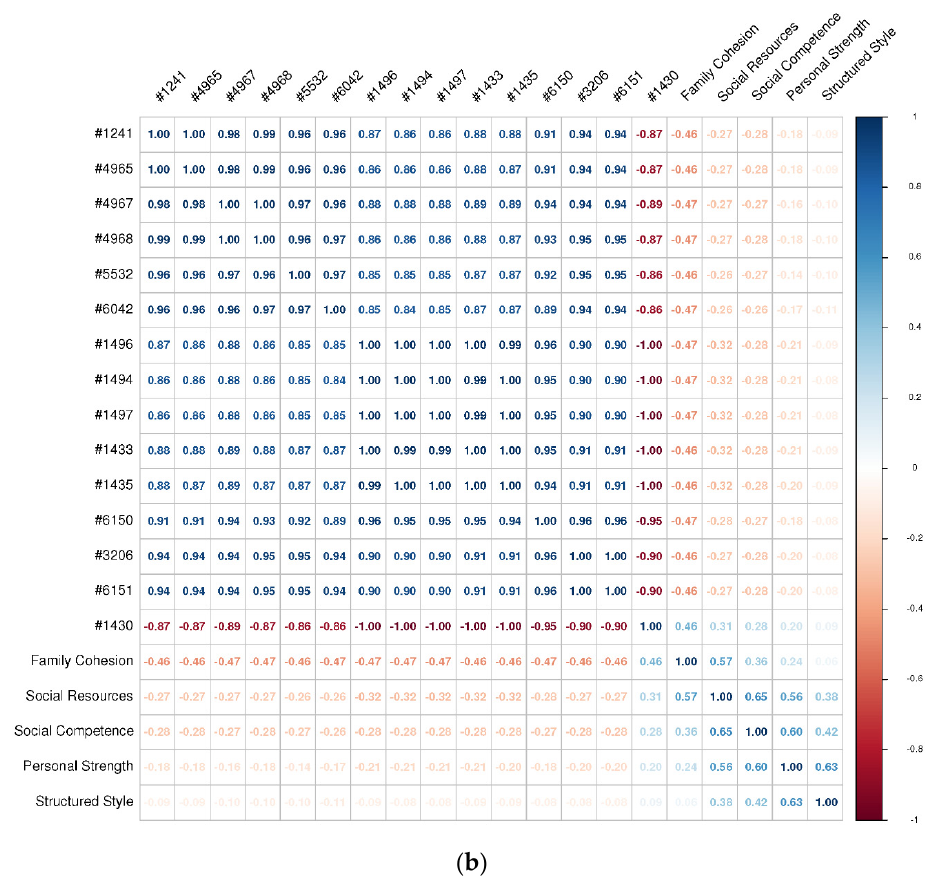
Figure 5. ( a ). The correlations between each RSA score and each ComParE2013 paralinguistic feature (only negative memories). Because there were many statistically significant correlations ( p < 0.05), only paralinguistic features with at least one |r| > 0.46 were included in this plot. #3910 = F0fi-